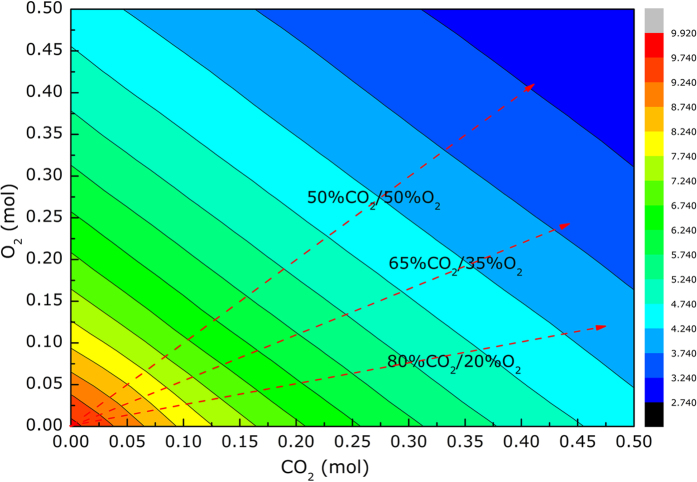
Contour of the syngas HHV (MJ/Nm3) in atmospheres of CO2/O2.